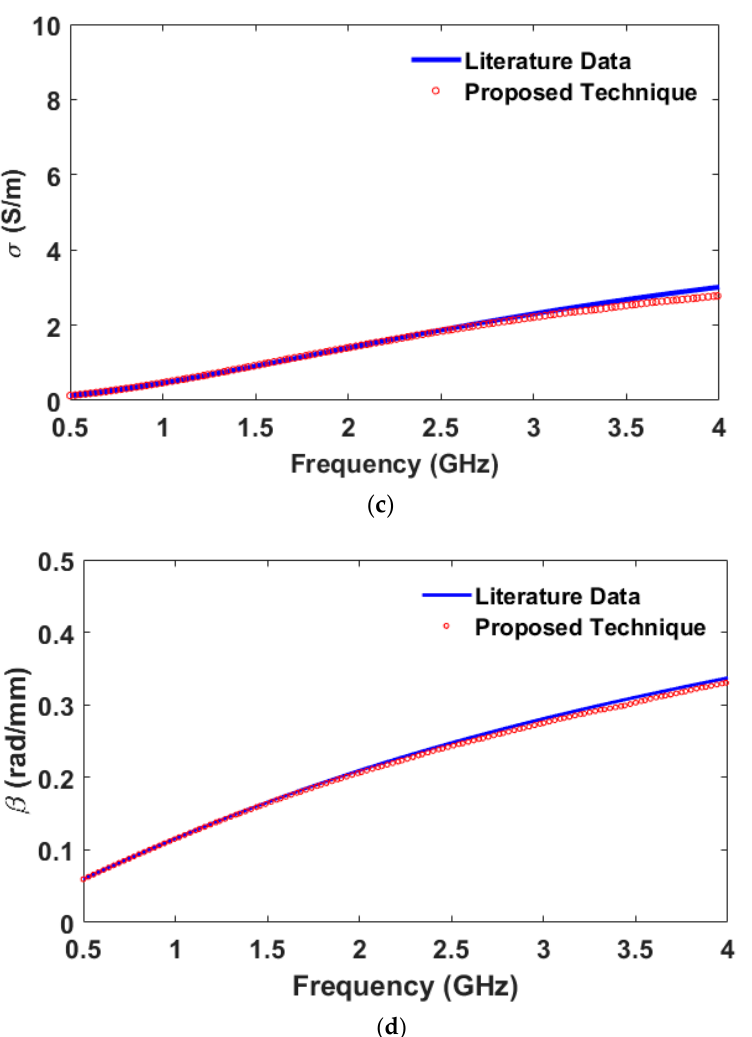
Figure 6. Sensor validation with ( a ) real part of the complex relative permittivity ( b ) imaginary part of the complex relative permittivity ( c ) electrical conductivity ( d ) phase constant using methanol as an unknown material.